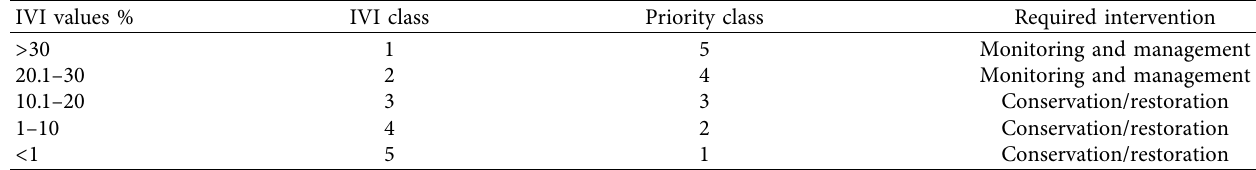
Table 4: Criteria for setting IVI classes and conservation priority based on IVI values.